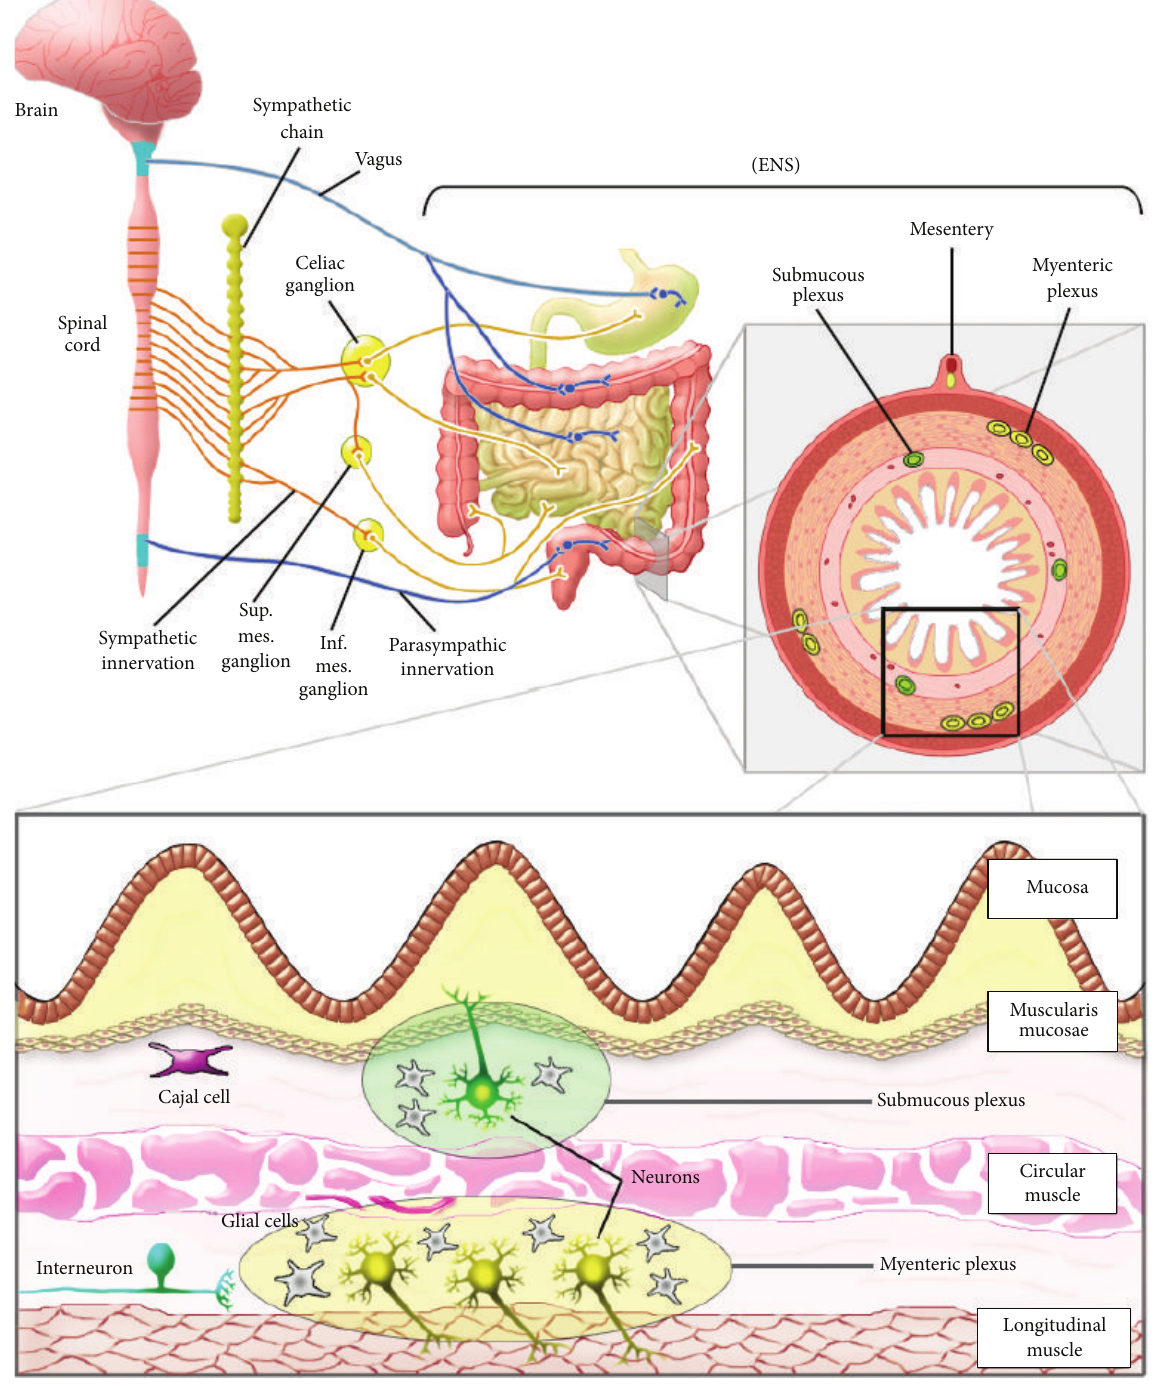
Figure 1: Schematic illustration showing the interaction between the central nervous system (CNS) and the enteric nervous system (ENS). The sympathetic and parasympathetic innervations interact with neurons in the gastrointestinal tract, passing the sympathetic innervations first through the celiac ganglion and the superior mesenteric ganglion (sup. mes. ganglion) and the inferior mesenteric ganglion (inf. mes. ganglion). The quadrant below the CNS and the ENS represents the intestinal mucosa and its myenteric and submucosal